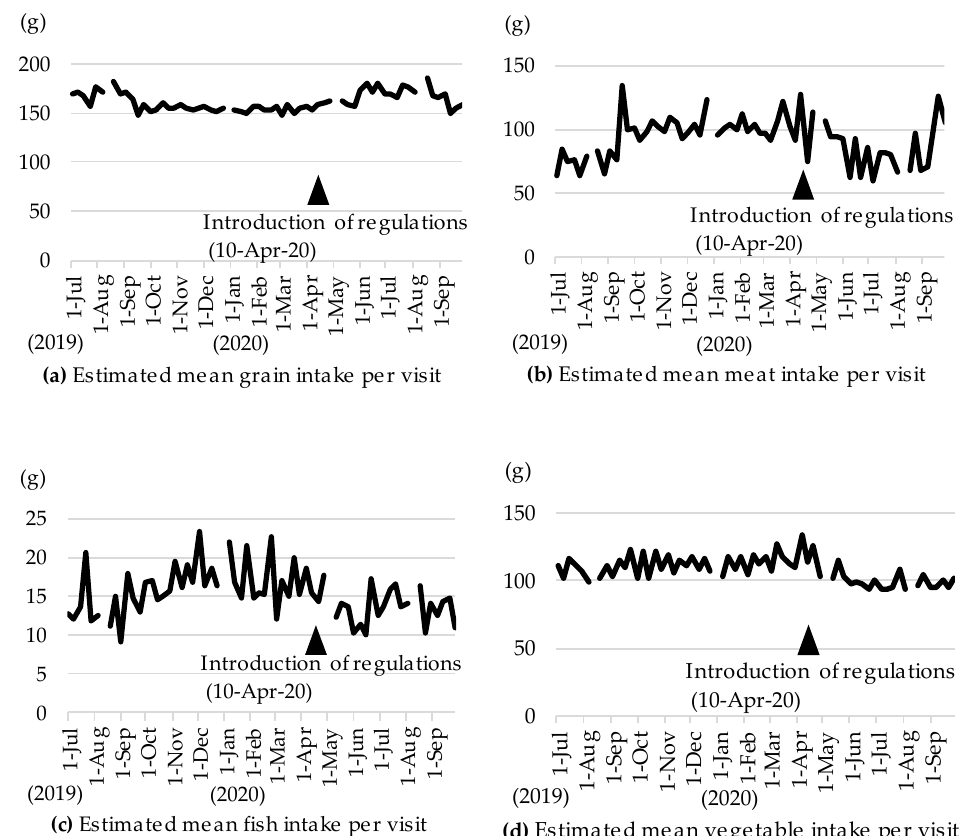
Figure 2. Estimated mean food intake per cafeteria visit from 1 July 2019 to 30 September 2020. Pandemic regulations in the workplace cafeteria were implemented on 10 April 2020. ( a ) Estimated mean grain intake per visit; ( b ) Estimated mean meat intake per visit; ( c ) Estimated mean fish intake per visit; ( d ) Estimated mean vegetable intake per visit.